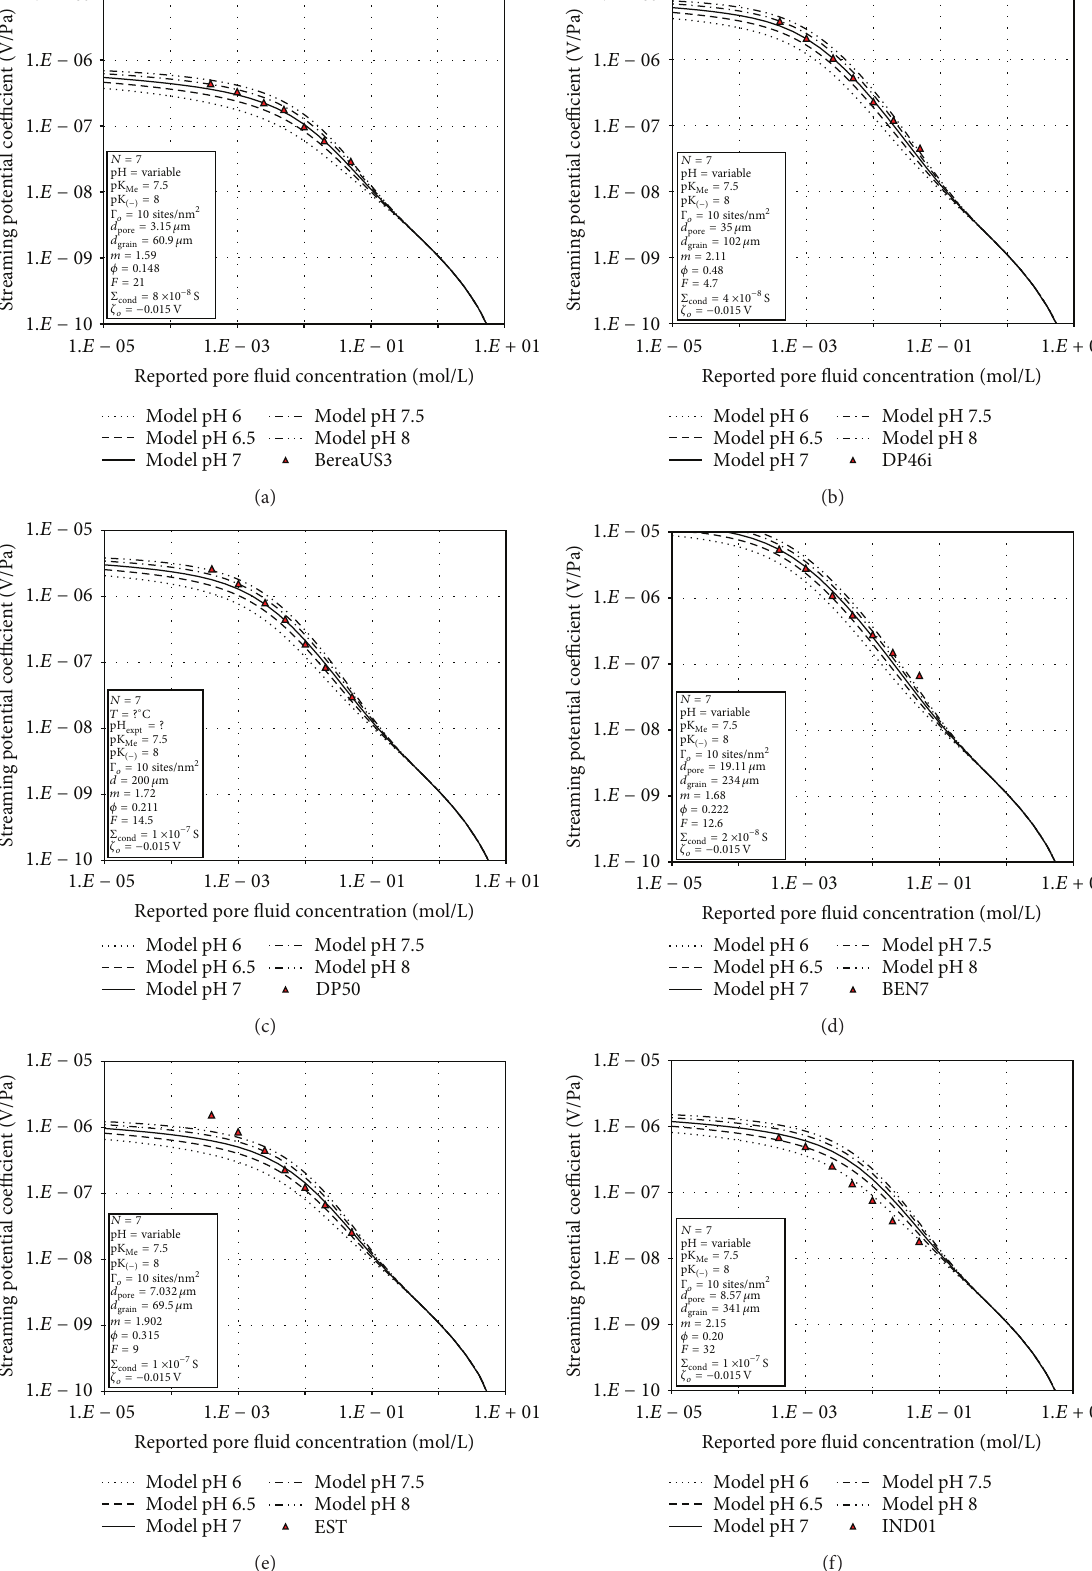
Figure 2: Streaming potential coefficient modelling using (2) for six samples from Luong and Sprik’s [1] data as a function of pore fluid salinity and pH together with the corresponding experimental measurements. (a) BereaUS3, Σ prot 𝑠 = 8 × 10 −8 S; (b) DP46i, Σ prot 𝑠 = 4 × 10 −8